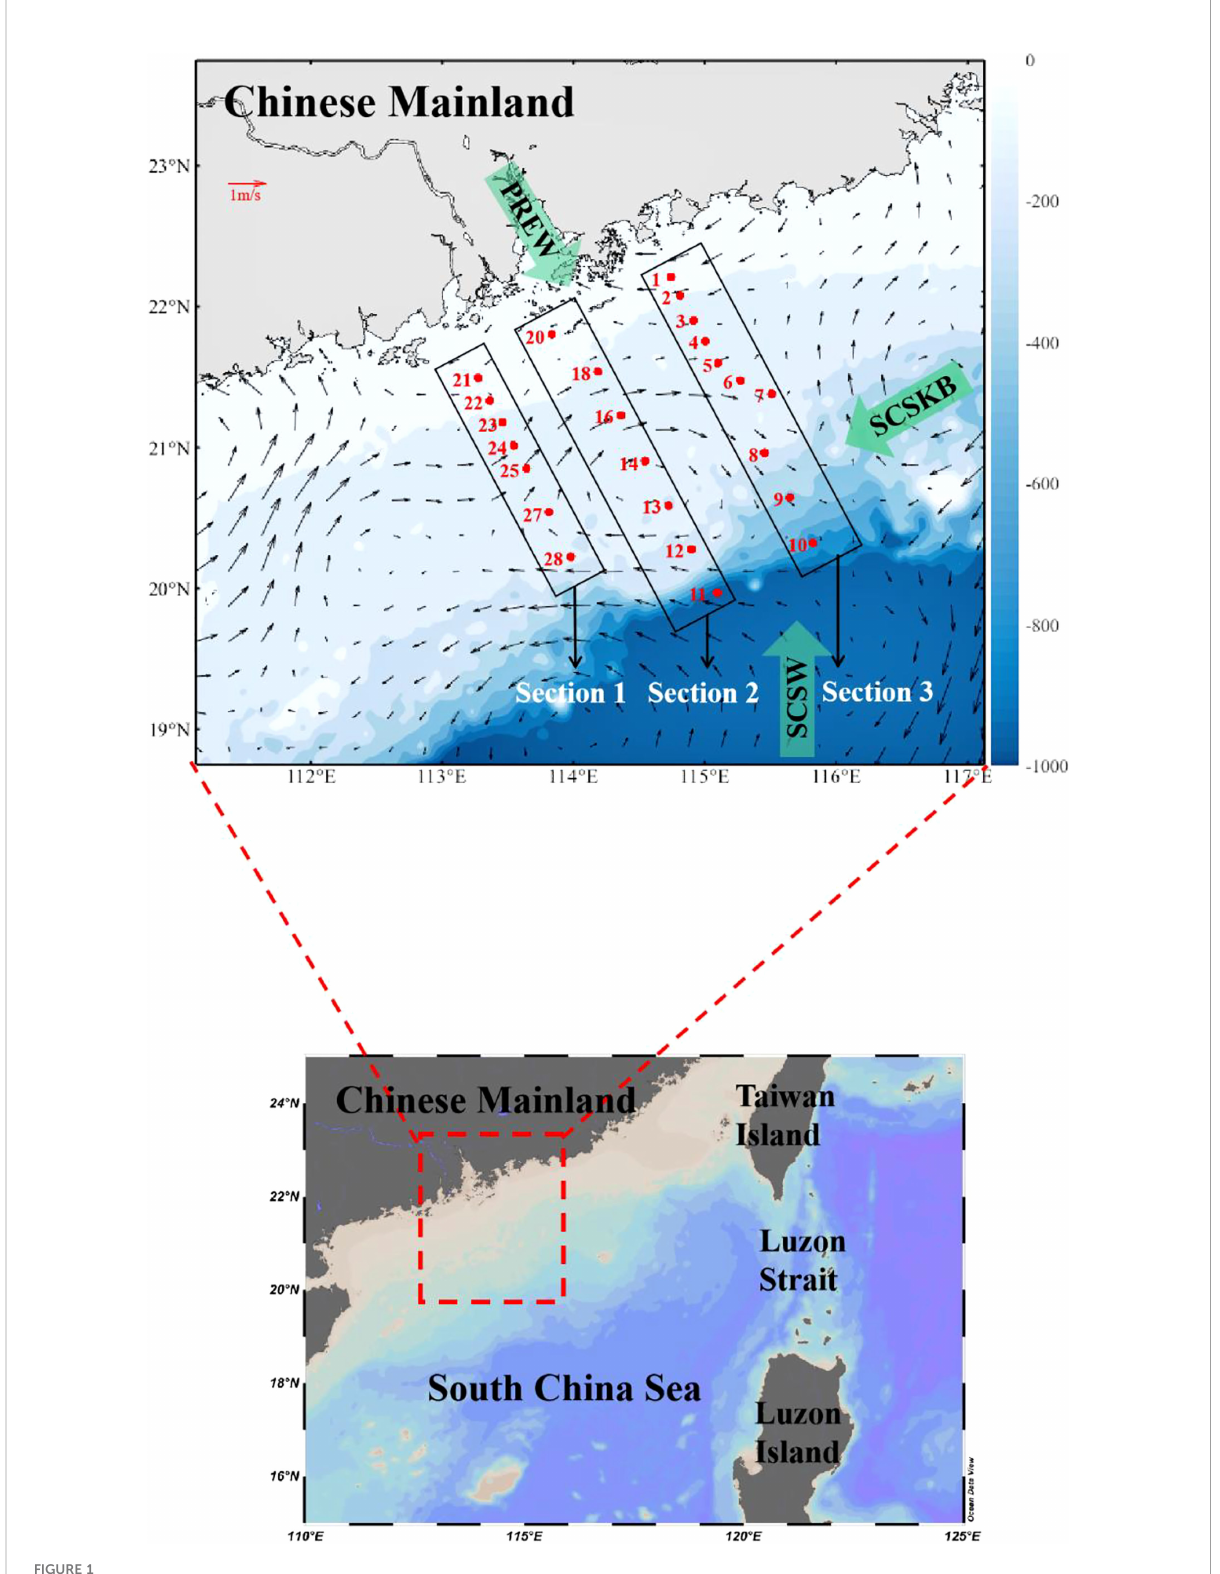
FIGURE 1 Sampling stations in the Pearl River Estuary during September 2015.The surface current vectors were also plotted. PREW, Pearl River fl ushing water; SCSW, South China Sea water; SCSKB, South China Sea Kuroshio